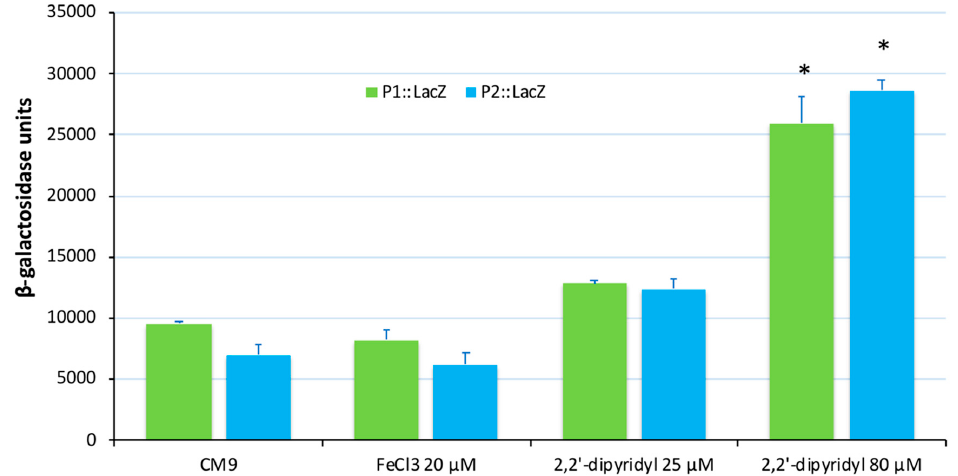
Figure 4. Transcriptional activity ( β -galactosidase units) of lacZ fusions to P1 and P2 potential promoters of V ordalii . β -galactosidase activities for promoter P1:: lacZ and promoter P2:: lacZ were measured in cells cultured in CM9 minimal medium, CM9 supplemented with 20 µM FeCl 3 , as an